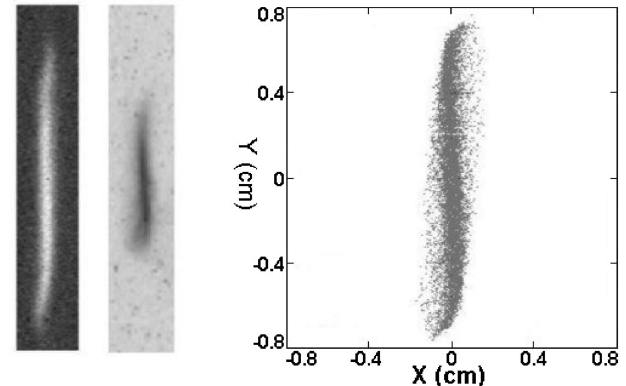
FIG. 1. Transverse distribution of the HTER beam. Left: two typical experiment results (courtesy of D. Edwards); right: PARMELA simulation